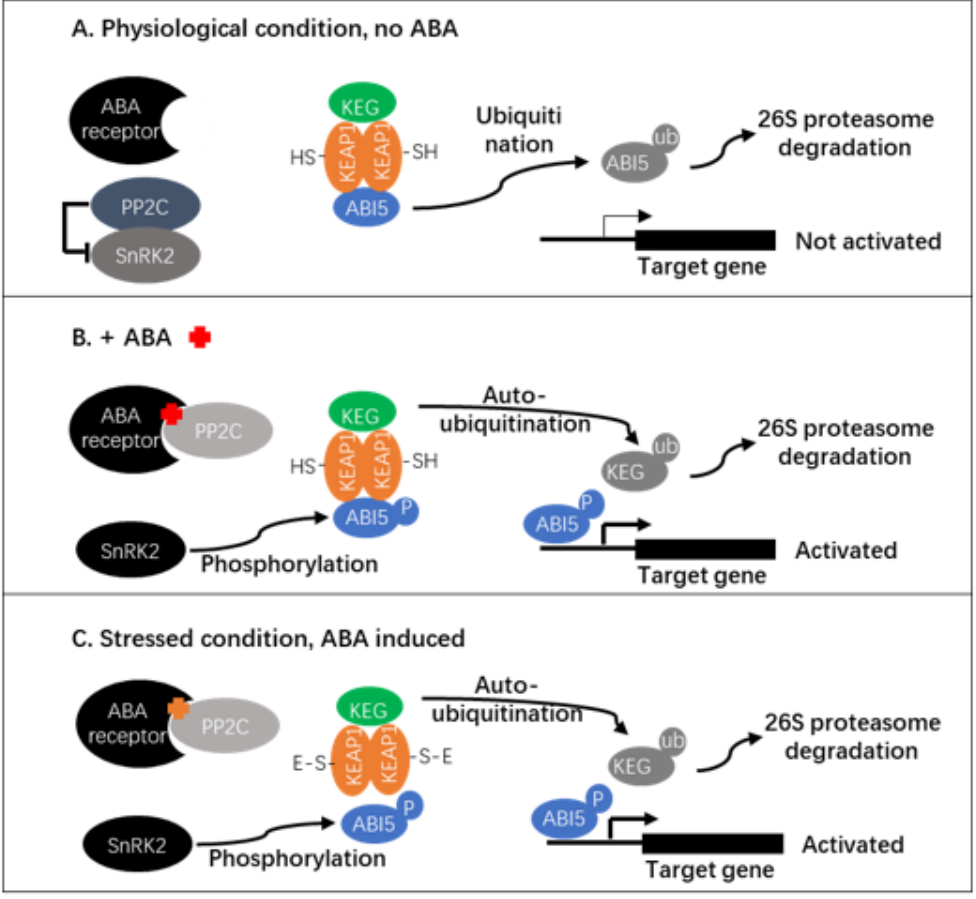
Figure 6. A hypothetical module of KEAP1–ABI5 in plants. Under physiological conditions, ABI5 is degraded and unable to activate its target genes (including itself) ( A ). When there is a high level of ABA ( B ) or under stress ( C ), the configuration of KEAP1 is changed due to reactions with electrophiles, and ABI5 is released from the complex. ABI5 is then phosphorylated and translocated to the nucleus and activates the transcription of target genes.